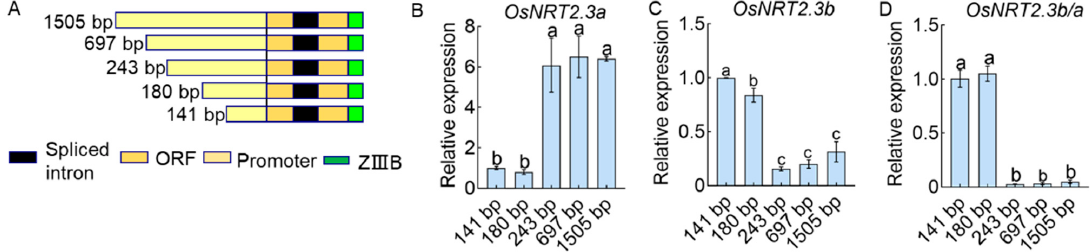
Figure 6. Effect of different OsNRT2.3 promoter lengths on OsNRT2.3a and OsNRT2.3b expression in rice. ( A ) Schematic representation of the different OsNRT2.3 promoter fragments 141, 180, 243, 697, and 1505 bp, driving the expression of the 437 bp open reading frames (ORF) of OsNRT2.3 and the ZIIIB reporter gene. Black frames, spliced intron. Brown frames, ORF of OsNRT2.3a and OsNRT2.3b . Yellow frames, promoters of OsNRT2.3 . Green frames, ZIIIB reporter gene, division OsNRT2.3a and OsNRT2.3b . Obtained transgenic lines planted in a solution containing 1.25 mM NH 4 NO 3 of IRRI. The expression of OsNRT2.3a ( B ) and OsNRT2.3b ( C ) in the lines of different lengths of OsNRT2.3 promoters was derived. ( D ) The expression ratio of OsNRT2.3b to OsNRT2.3a in the lines of different lengths of OsNRT2.3 promoters was derived. Error bars: SE (n = 3). Significant differences between the lines are indicated by different letters ( p < 0.05).